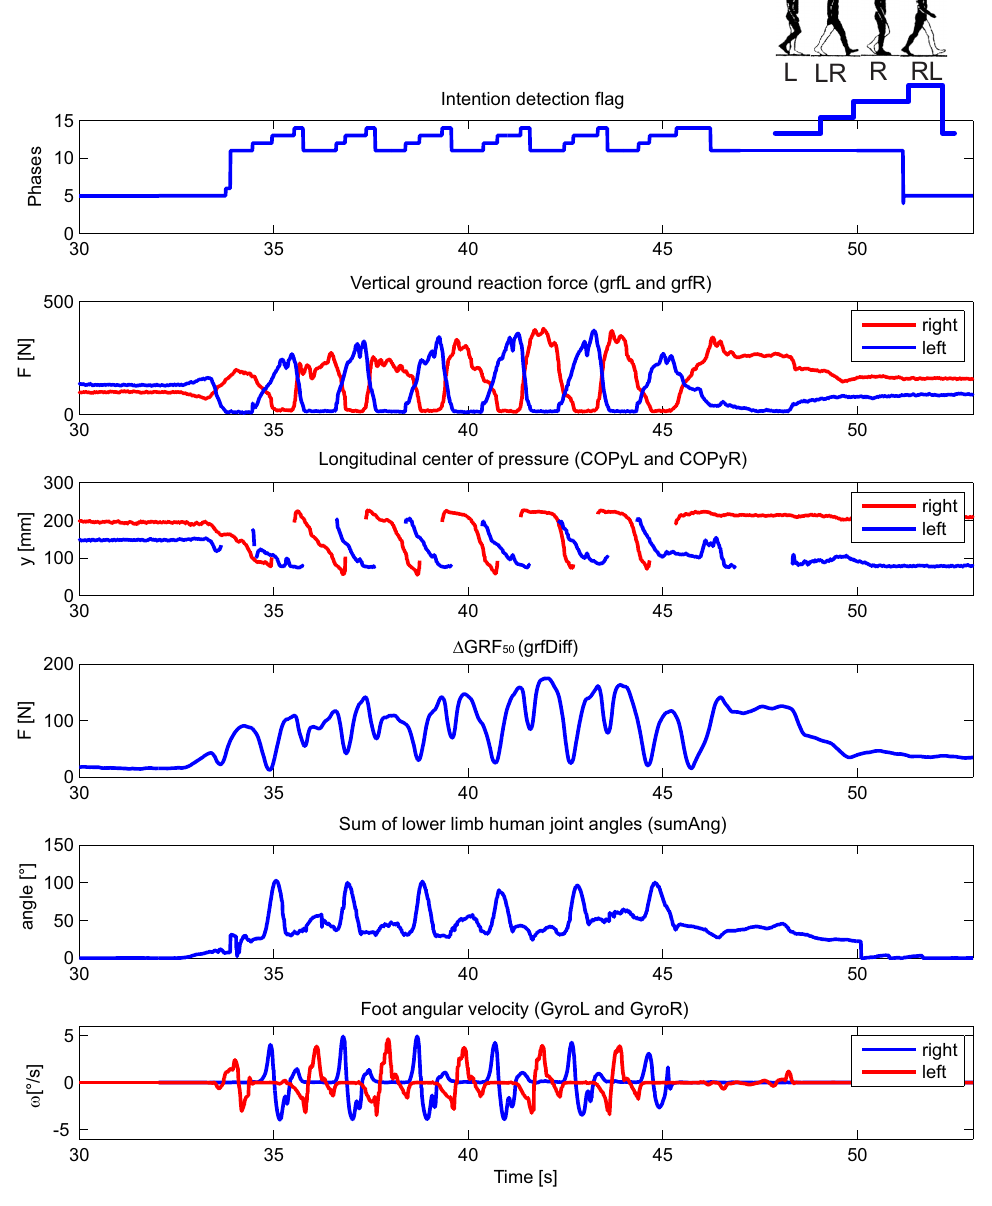
walking trial. In the top right corner, the pattern sequence for a single stride is illustrated with L for left stance, L-R for left-right double stance, R for right single stance and R-L for right-left double stance. The phase flag values correspond to the values 11, 12, 13 and 14, defined in Table